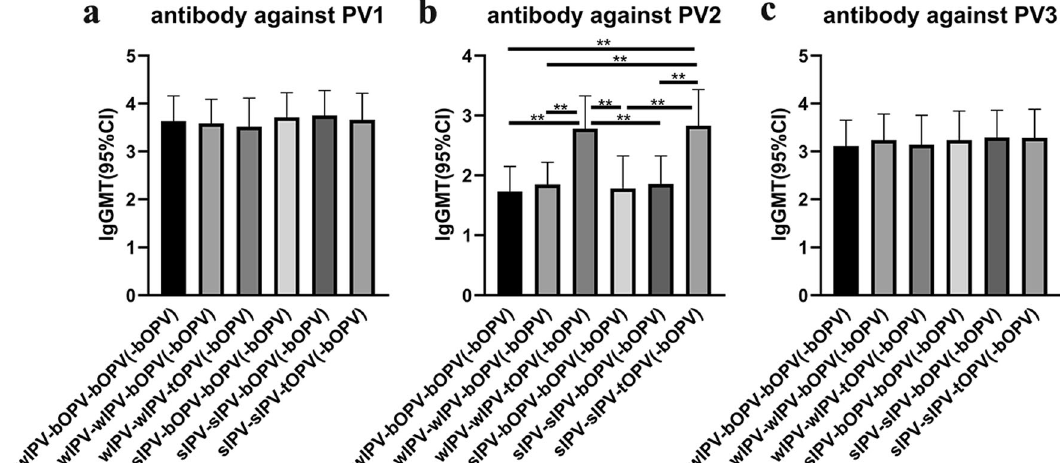
Fig. 4 GMT for neutralizing antibody against PV1, PV2, and PV3 at 28 days after booster immunization at 48 months of age. Differences in antibody levels between groups were compared after log-transformation of the GMT (95%CI). Statistical test: Kruskal – Wallis test; * p < 0.05; ** p < 0.001. error bars: Standard Deviation (s.d.). a GMT for neutralizing antibody against PV1. b GMT for neutralizing antibody against PV2. c GMT for neutralizing antibody against PV3. wIPV-bOPV-bOPV(-bOPV): n = 58; wIPV-wIPV-bOPV(-bOPV): n = 73; wIPV-wIPV-tOPV(-bOPV): n = 109; sIPV-bOPV-bOPV(-bOPV): n = 20; sIPV-sIPV-bOPV(-bOPV): n = 71; sIPV-sIPV-tOPV(-bOPV): n =